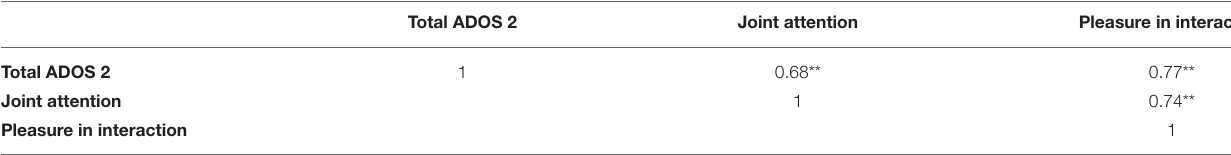
TABLE 3 | Correlation values between the first evaluation results in the identified items and the total of the second evaluation.